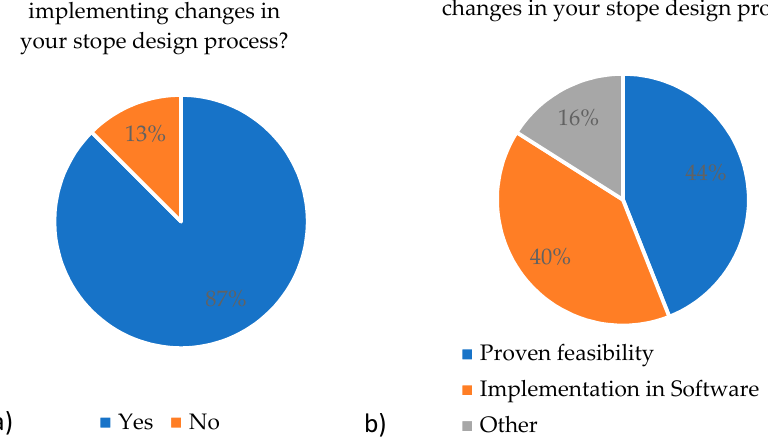
Figure 15. Willingness to implement changes in the stope design process ( a ) and the acceptance conditions to implement new methods ( b ) (other requirements identified were realized benefits, reliability, predictability, faster process, and new personnel).